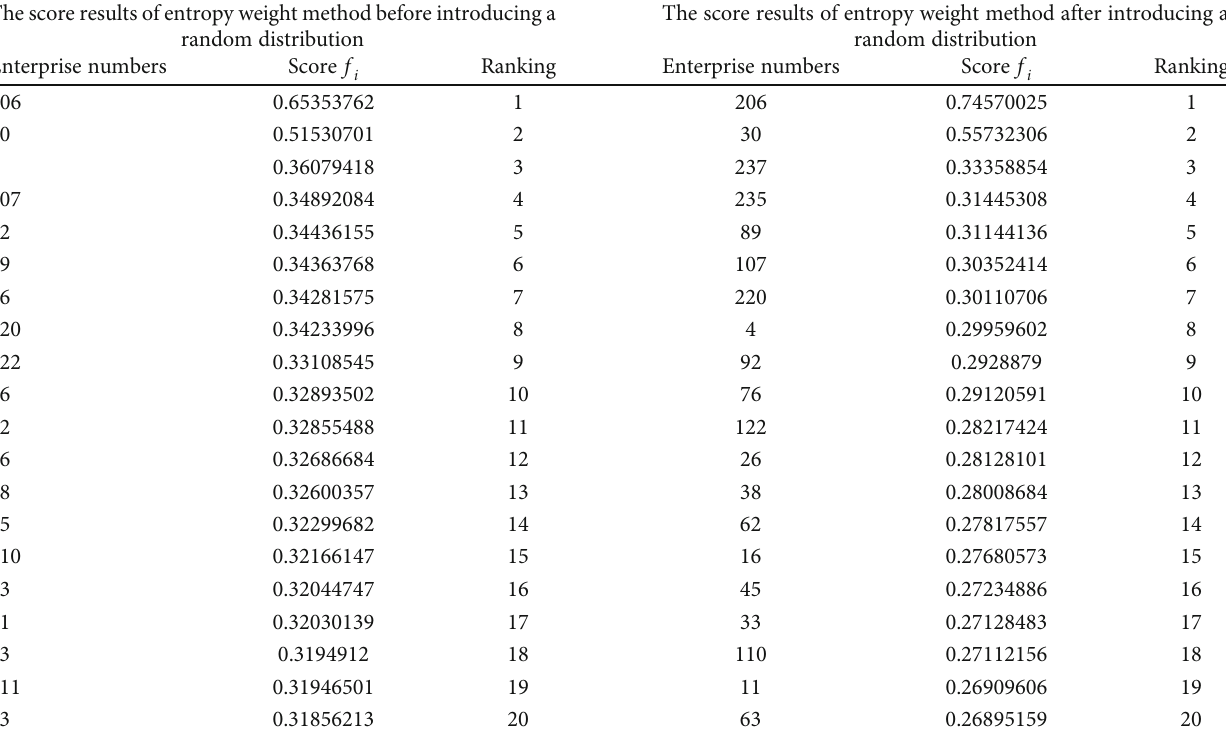
Table 3: Changes in scores and rankings of the top 20 companies after the introduction of random